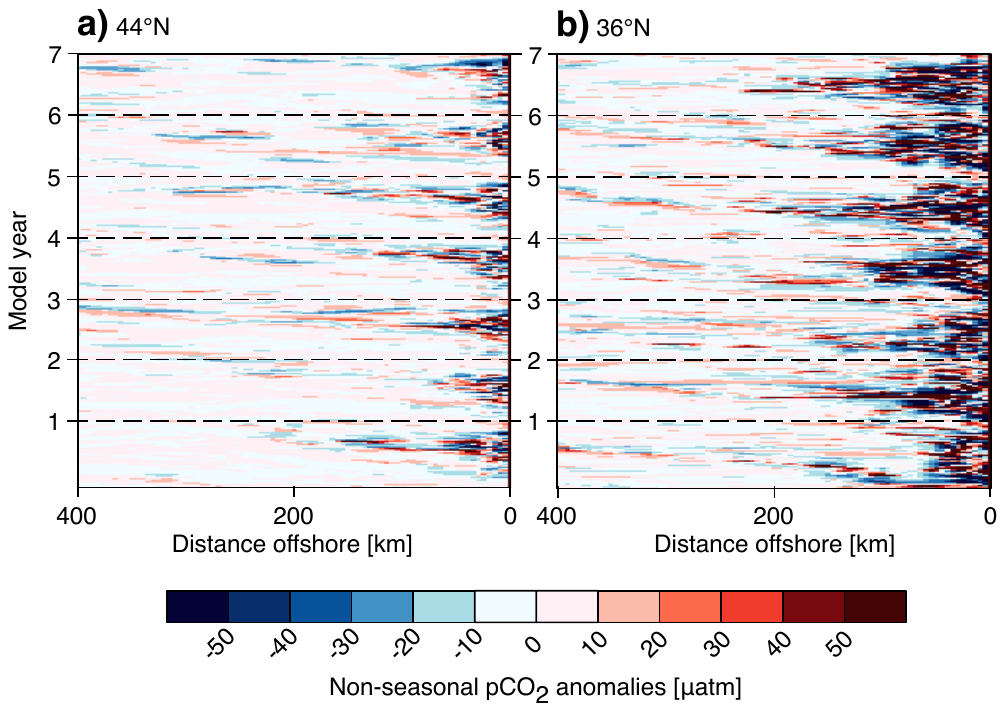
Fig. 11. Hovmöller diagrams representing nonseasonal p CO 2 anomalies as a function of distance offshore, based on 2–day output spanning seven consecutive model years. The anomalies were computed as the difference between the total p CO 2 over the seven analysis years and a seasonal fitted mean over the same seven years. Panel (a) shows a transect at around 44 ◦ N, while panel (b) depicts a transect at around 36 ◦ N. The transects run roughly along the midlines of the northern and central subdomains,